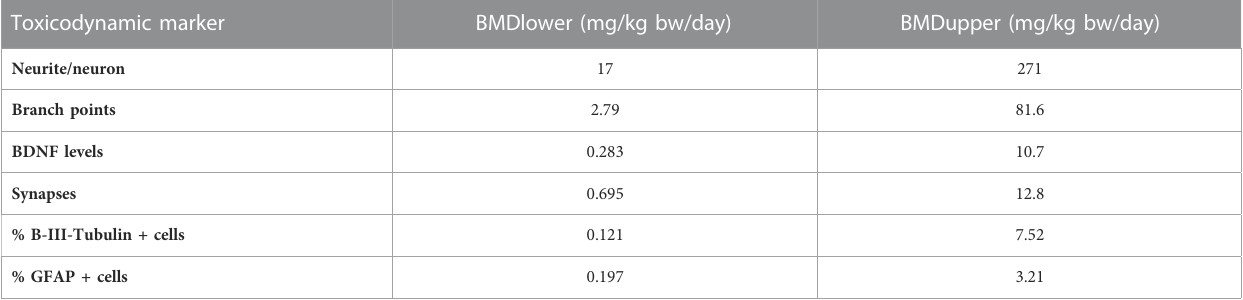
TABLE3BMDcon fi denceintervalandtotalmaternaloraldosepredictedbasedonaverageCPFconcentrationaskineticmetricfortheinvestigatedtoxicodynamic markers. Toxicodynamic